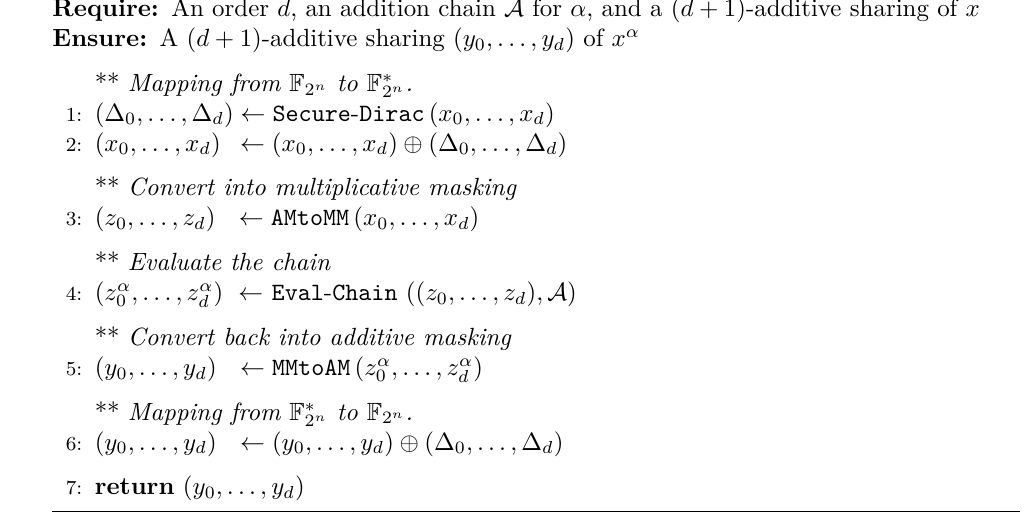
Algorithm 6 Secure Power Function